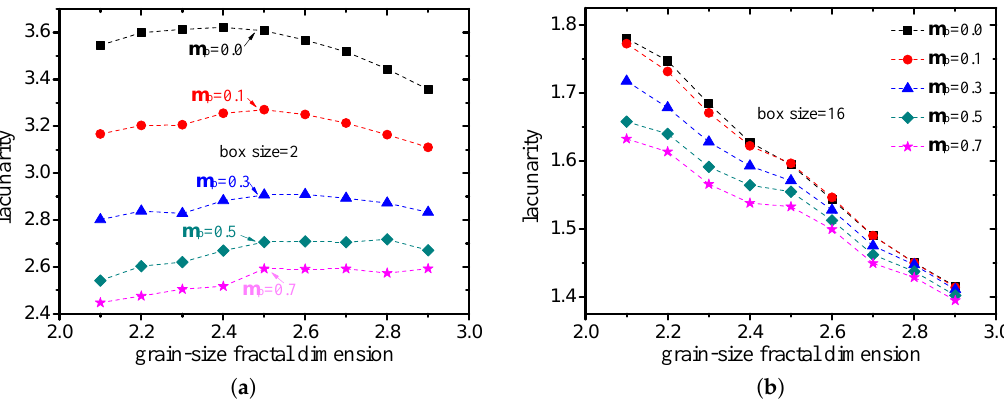
Figure 14. Lacunarity of pore structures with different grain-size fractal dimensions and friction coefficients (( a ) box size = 2 ( < minimum particle size); ( b ) box size = 16 ( > minimum particle size)).